Question: Write the caption for this figure.
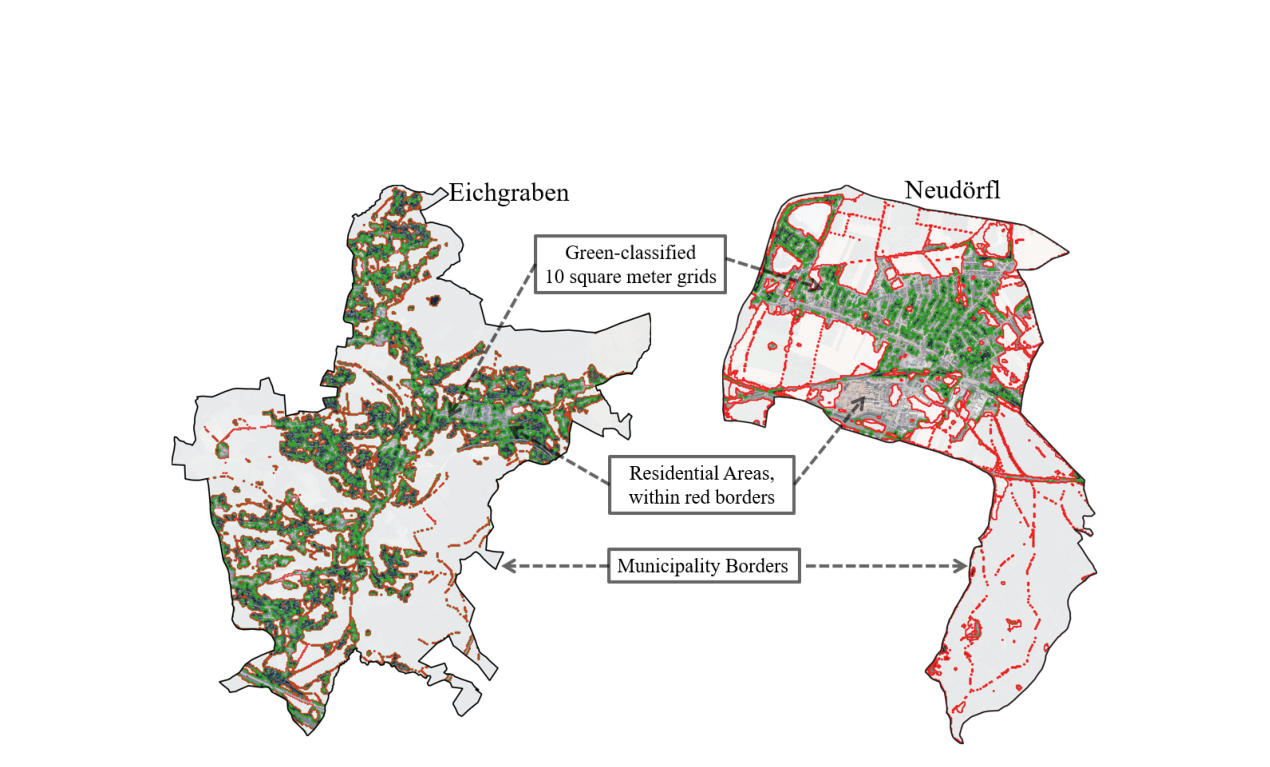
Answer: Comparing the greenness of two Austrian municipalities in 2020, on the left, Eichgraben from Niederösterreich, and on the right, Neudörfl from Burgenland. Both have similar total areas, residential areas, and similar population sizes. However, regarding the greenness of the municipalities using the RGS, Eichgraben has the highest RGS score of all municipalities, while Neudörfl is in the bottom 30% of municipalities ranked by RGS.